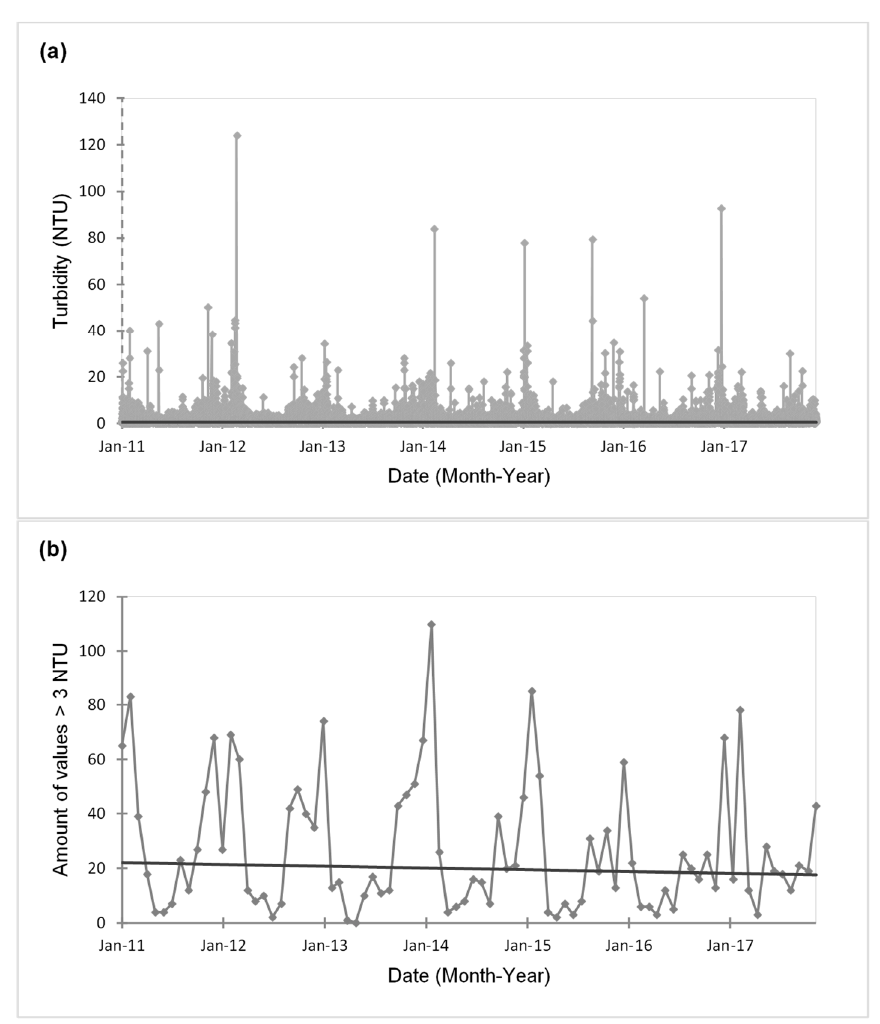
Figure 4. City of Salta. Mann–Kendall analysis for turbidity. ( a ) Analysis using all available turbidity data; ( b ) Amount of values greater than 3 NTU per month per year. The trend line is shown in dark grey.